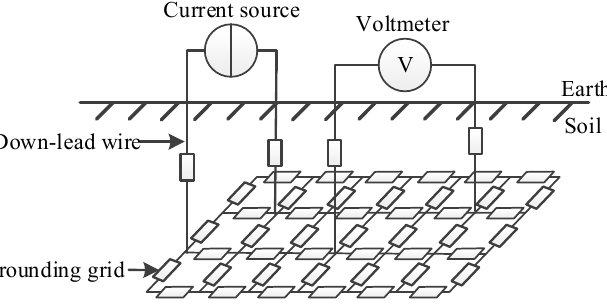
Figure 1. Equivalent schematic of the grounding grid.